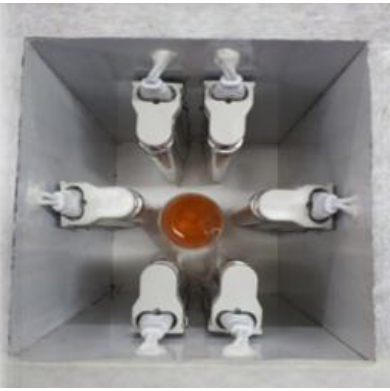
Figure 1. Scheme of the photoreactor system. UV–C Lamp (6 (4 W) UV–C Lamp